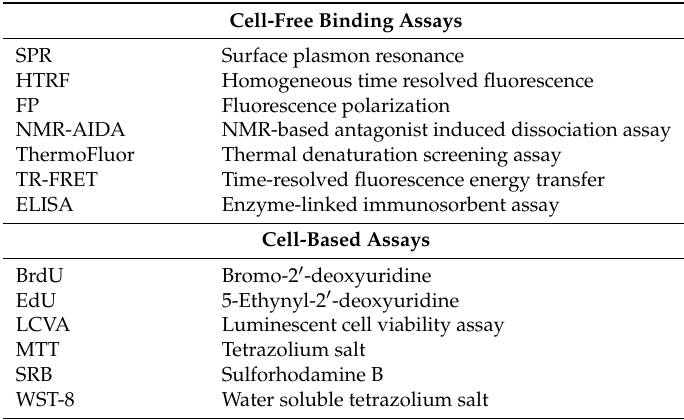
Table 1. Cell-free and cell-based in vitro